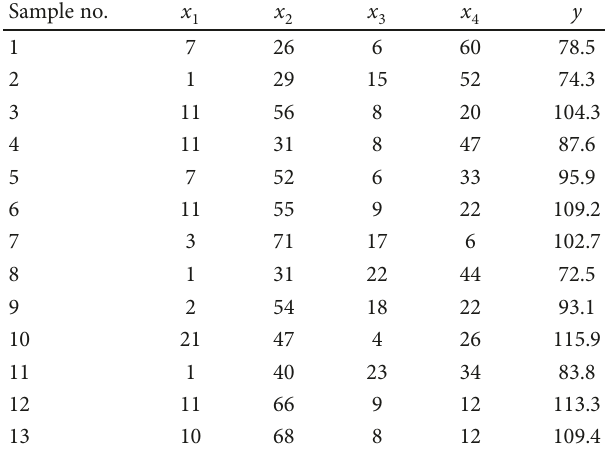
Table 1: Data on relations between content x and heat y of four components of Hald